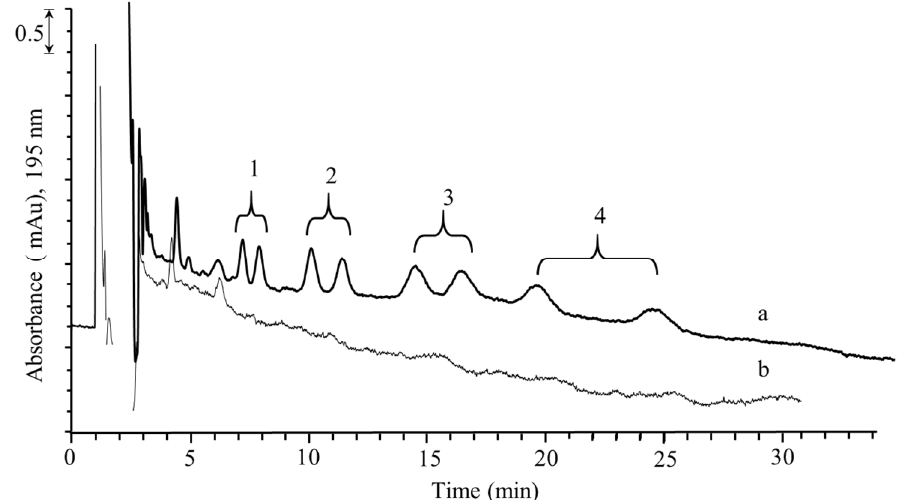
Figure 6. UV chromatograms of milk samples after DLLME–nano-LC–UV method: (a) spiked with selected antifungal drugs, (b) blank sample. Experimental conditions: spiked racemic mixture 5–15 µg/mL ng. For further information, see Figure 5 and text.